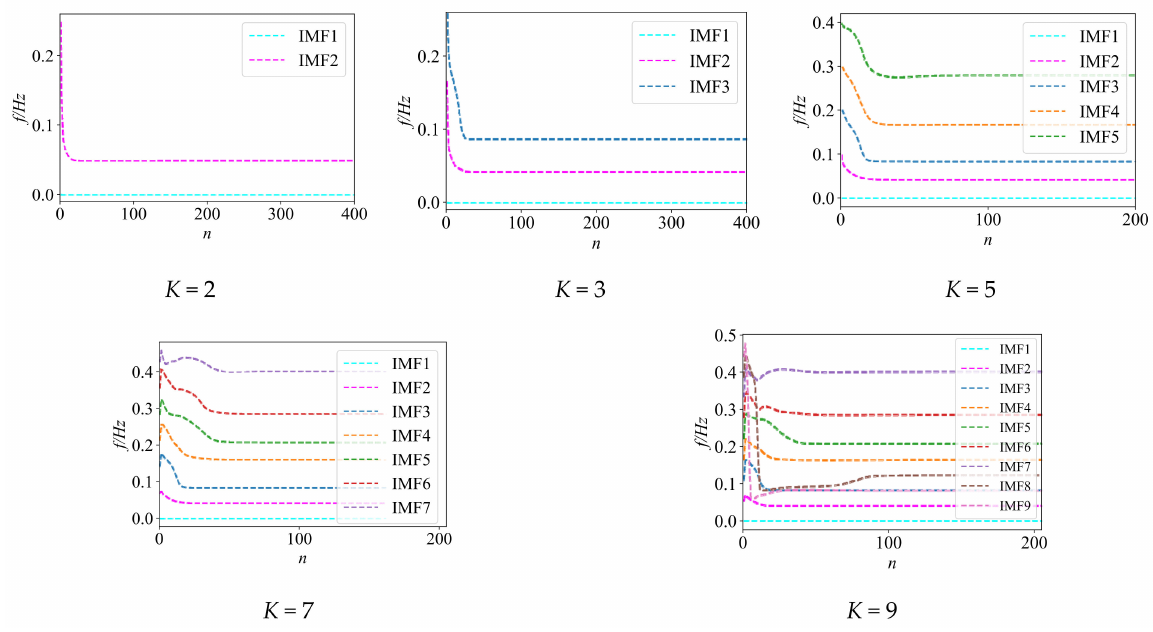
Figure 1. Sample center frequency iteration curves in different